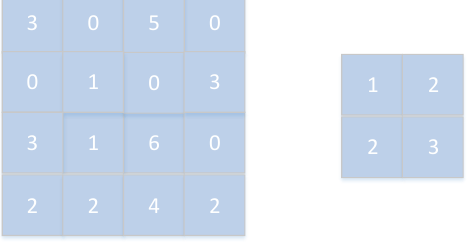
Figure 3. Average Pooling process